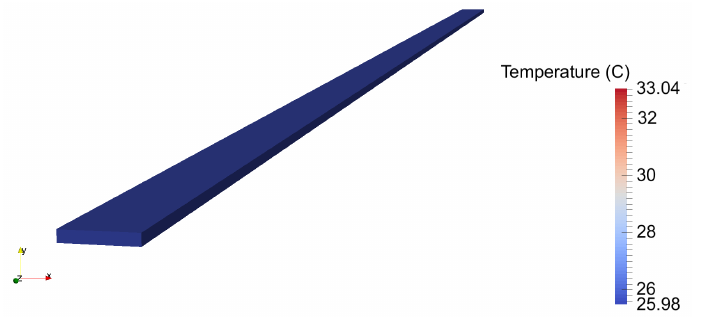
Figure 15. Temperature field at t = 50-s term for ω 1 = 2.45 GHz, when the electric field is polarized in the normal direction with respect to the fiber orientation.